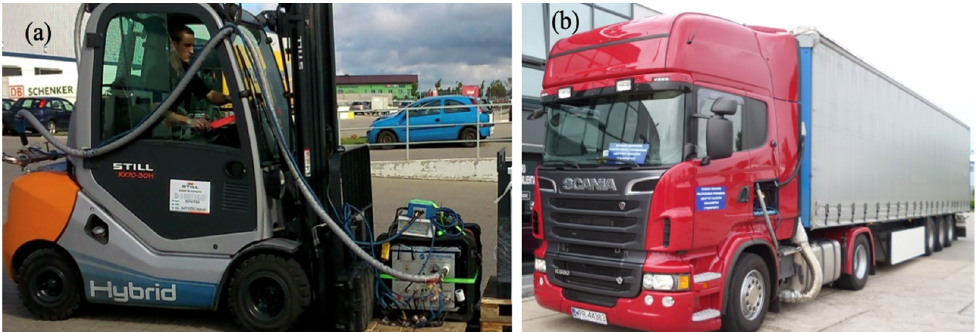
Figure 1. Research objects ( a ) forklift ( b ) tractor-trailer. The HDV vehicle was fitted with an 8-cylinder 15.6 dm 3 diesel engine. Its maximum power output is 412 kW @1900 rpm. The vehicle was Euro V compliant. Additionally,